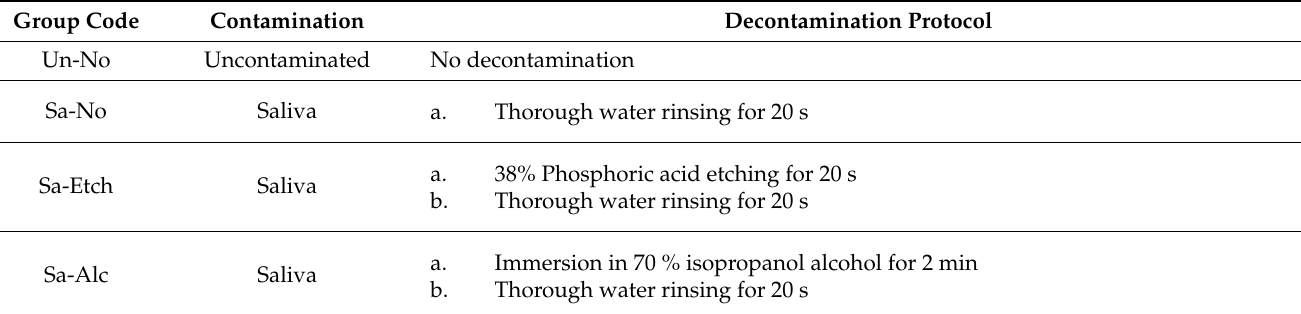
Table 2. Contamination and decontamination protocols